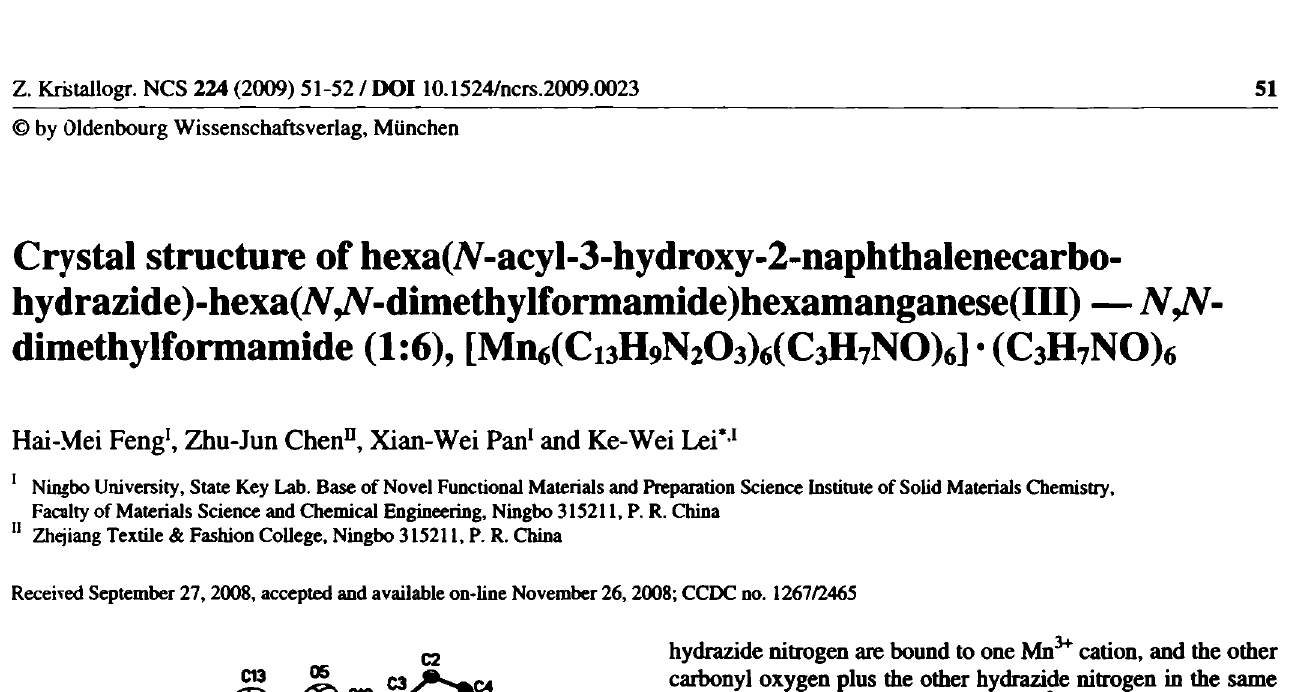
Table 1. Data collection and handling.